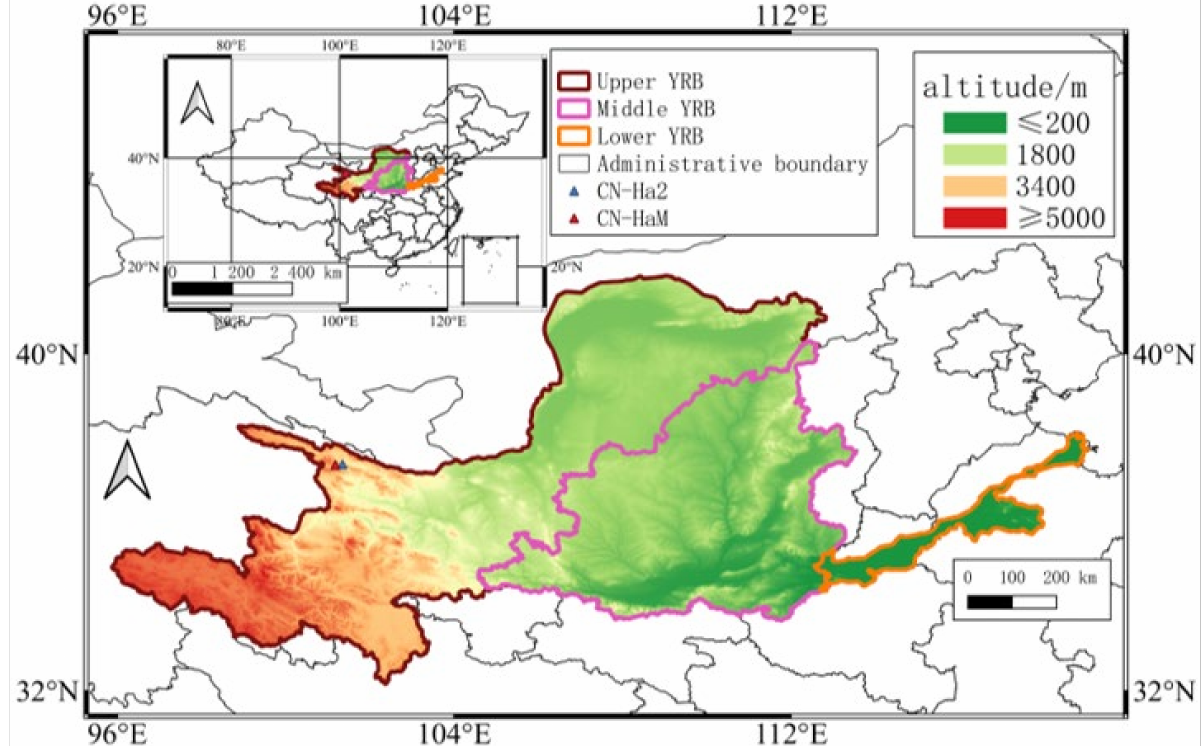
Figure 2. The geographical location of the Yellow River